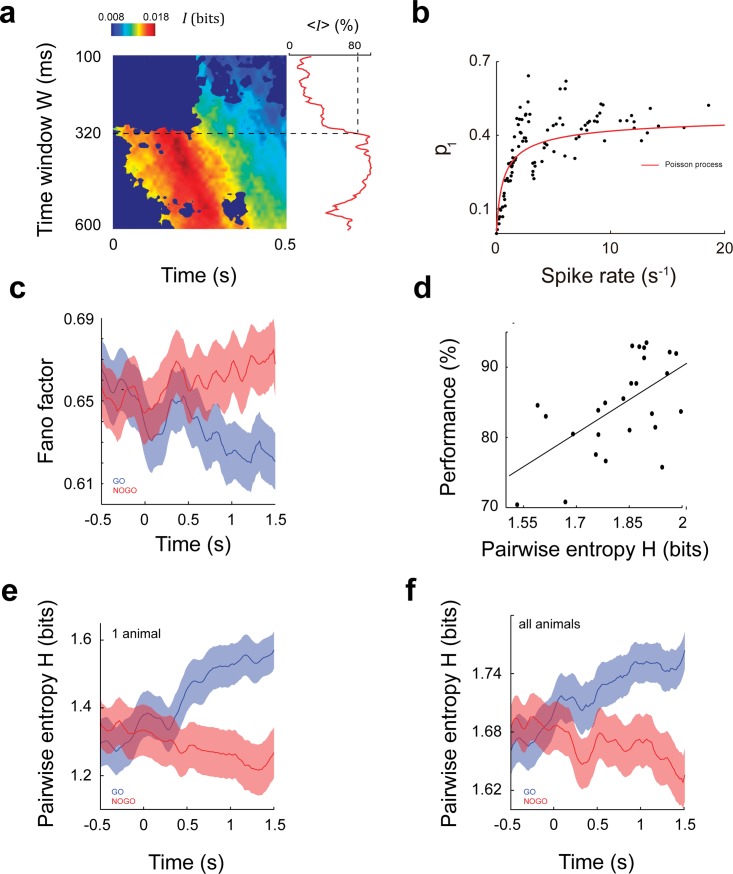
Pairwise entropy and correlation in the PFC.(a) Mutual information I between stimuli and PFC neurons depends on the size of the analysis window and the time from stimuli onset. We computed Mutual information for window sizes ranging from W = 100 ms to W = 600 ms centred at a time t, which varied from t = 0 ms to t = 500 ms. The averaged across time value <I> increases significantly with the window size, reaching 80% of the maximum at a window size of 320 ms (dashed line). (b) Relationship between binary model and firing rate. The plot depicts p1, the probability of finding a PFC neuron firing over its average across trials, versus the associated average firing rate, computed in a 320 ms window centred at t = 0.5 s. Each dot represents one out of 95 PFC neurons. The red line is the theoretically expected p1, assuming that neurons fire following a Poisson distribution. As firing rate becomes higher, p1 approaches 0.5, which is the expected value for a symmetric probability density function. (c) Fano factor computed for all PFC neurons during GO and NOGO trials. Comparing to basal values, neurons reduced their Fano Factor only during correct GO trials and after stimulus onset (p<0.05, Wilcoxon signed-rank test). (d) Behavioural performance increases with pairwise entropy (lineal regression slope = 0.31, CI 95% = [0.12, 0.49]). Each dot represents one session. (e-f) Pairwise entropy for GO trials became higher than for NOGO trials after 0.5 s (P<0.05, Sign test). The effect can be observed in each animal (e) and in the pool consisting of all neurons from all animals (f).